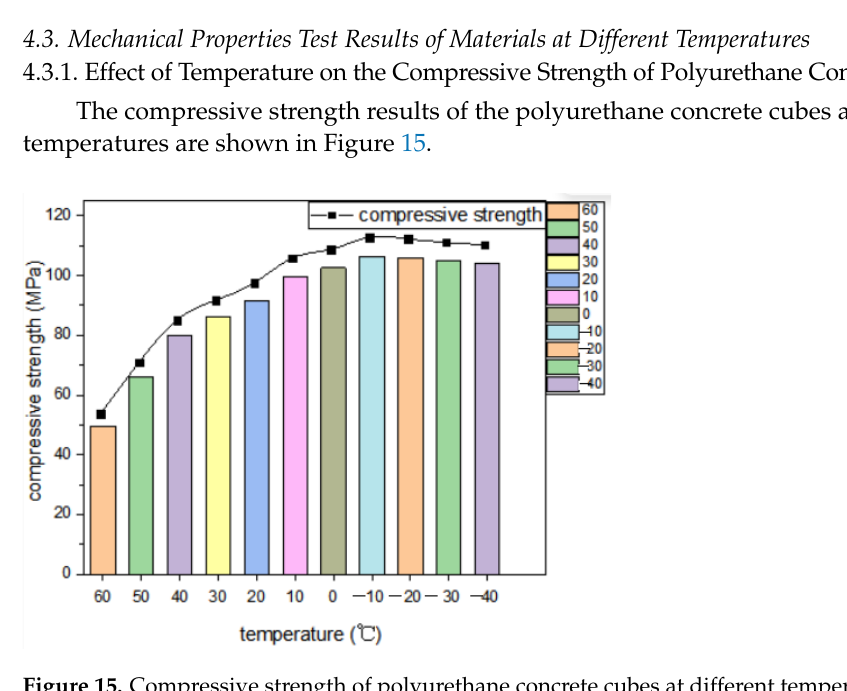
Figure 15. Compressive strength of polyurethane concrete cubes at different temperatures.